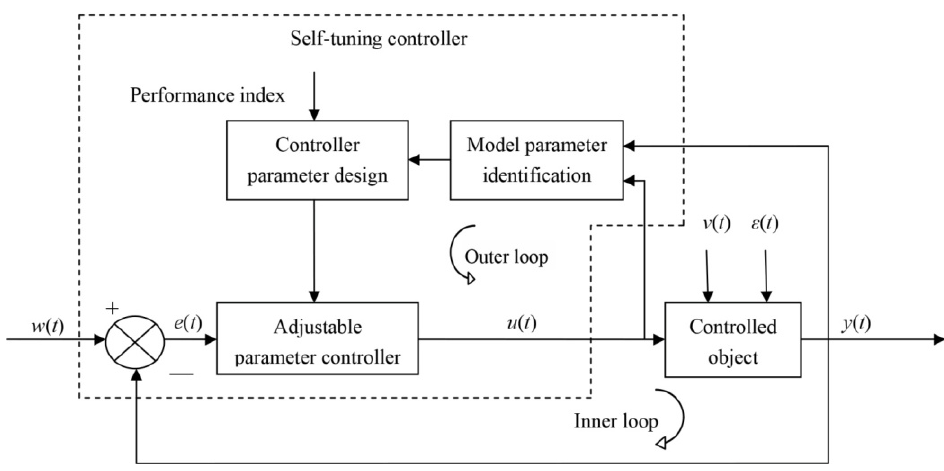
Figure 3. Structure diagram of adaptive control system.